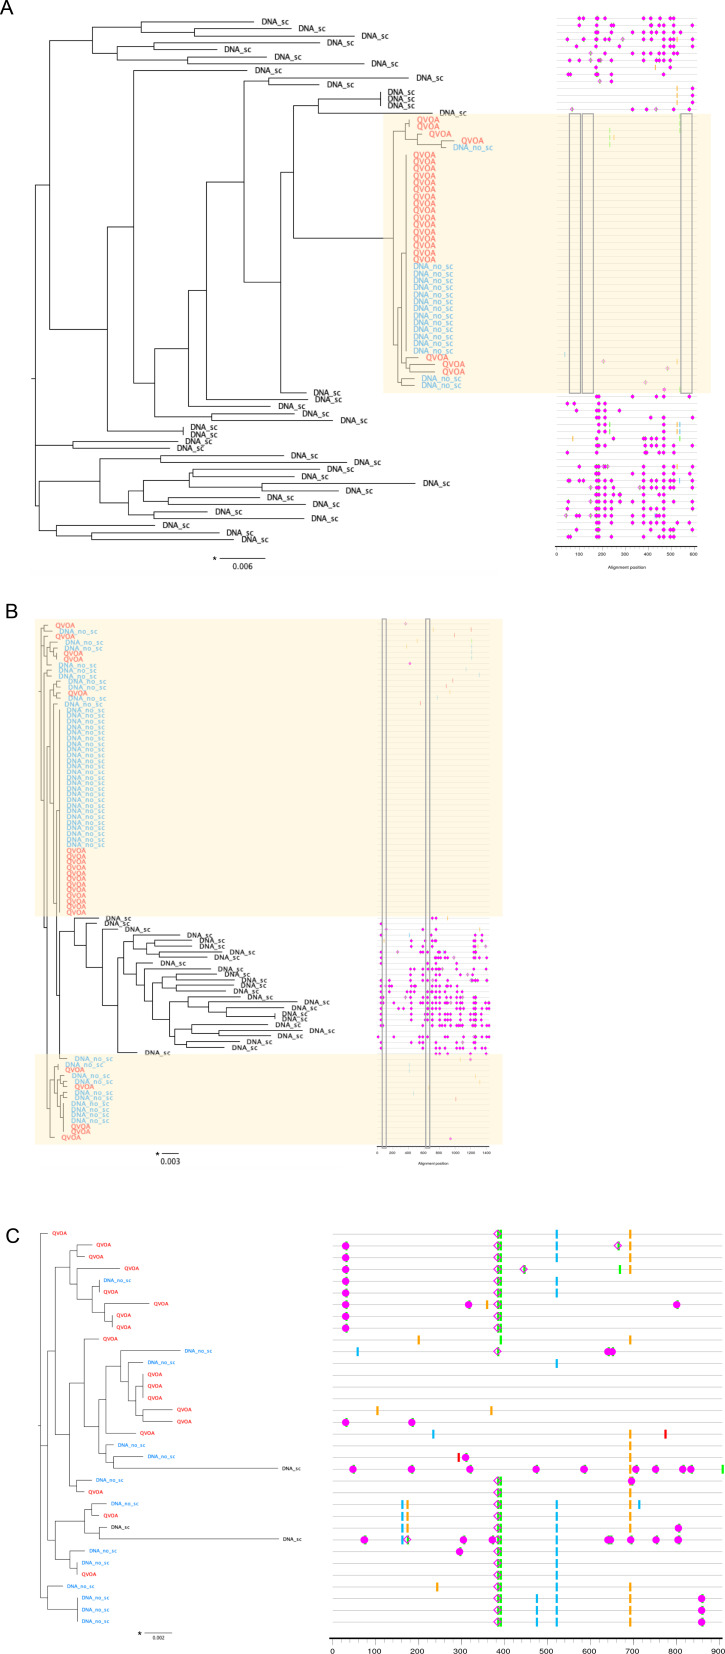
Outgrowth virus sequences and DNA sequences on neighbor-joining phylogenetic trees.Phylogenetic trees displaying longitudinal outgrowth virus sequences (red text) and DNA sequences, intact (blue text, DNA no stop codon (DNA no_sc)) and non-intact (black text, DNA stop codon (DNA_sc)) from resting CD4+ T cells in two participants (A–C). Highlighter plots showing differences between outgrowth virus sequences and intact DNA sequences (shaded in yellow) for HIV nef (A), and HIV gag (B) in participant 00728, and HIV Gag (C) in participant 00720. Variants are compared to the consensus sequence. A, C, T, and G mismatches, gaps, APOBEC and G to A mutation are shown in green, blue, orange, red and gray, purple and open purple square, respectively. Nucleotide numbering is relative to the reference strain HXB2. Mapped T cell responses are indicated by a gray box. The genetic distance is shown by scale bar (indicated with an asterisk), showing the number of nucleotide substitutions out of 1000 bp.